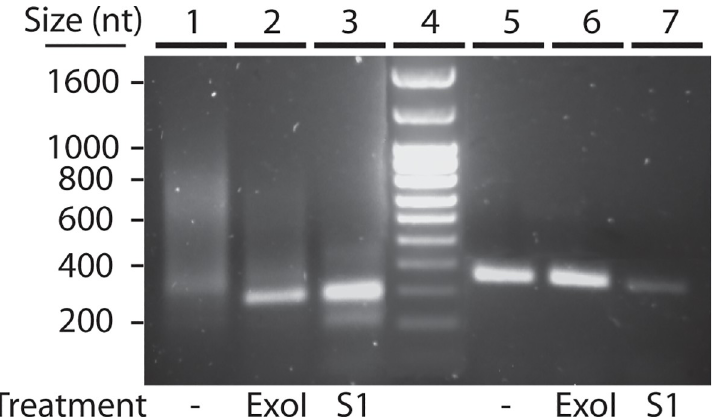
Fig 1. Analysis of the structure of the terminal region of the D . discoideum rDNA palindrome. Total DNA was extracted from D . discoideum AX4 cells and either non-treated (lanes 1, 5), digested with the 3’-5’ DNA single stranded exonuclease I (lanes 2, 6), or the DNA single-stranded specific nuclease S1 (lanes 3, 7). After treatment, the terminal region of the rDNA palindrome was amplified by PCR (lanes 1–3). A region of the nola4 gene was also amplified as control (lanes 5–7). The migration of the Ladder VII molecular weight marker (Nzytech, Lisbon, Portugal) is shown in lane 4 and the size of the fragments indicated at the left of the picture.